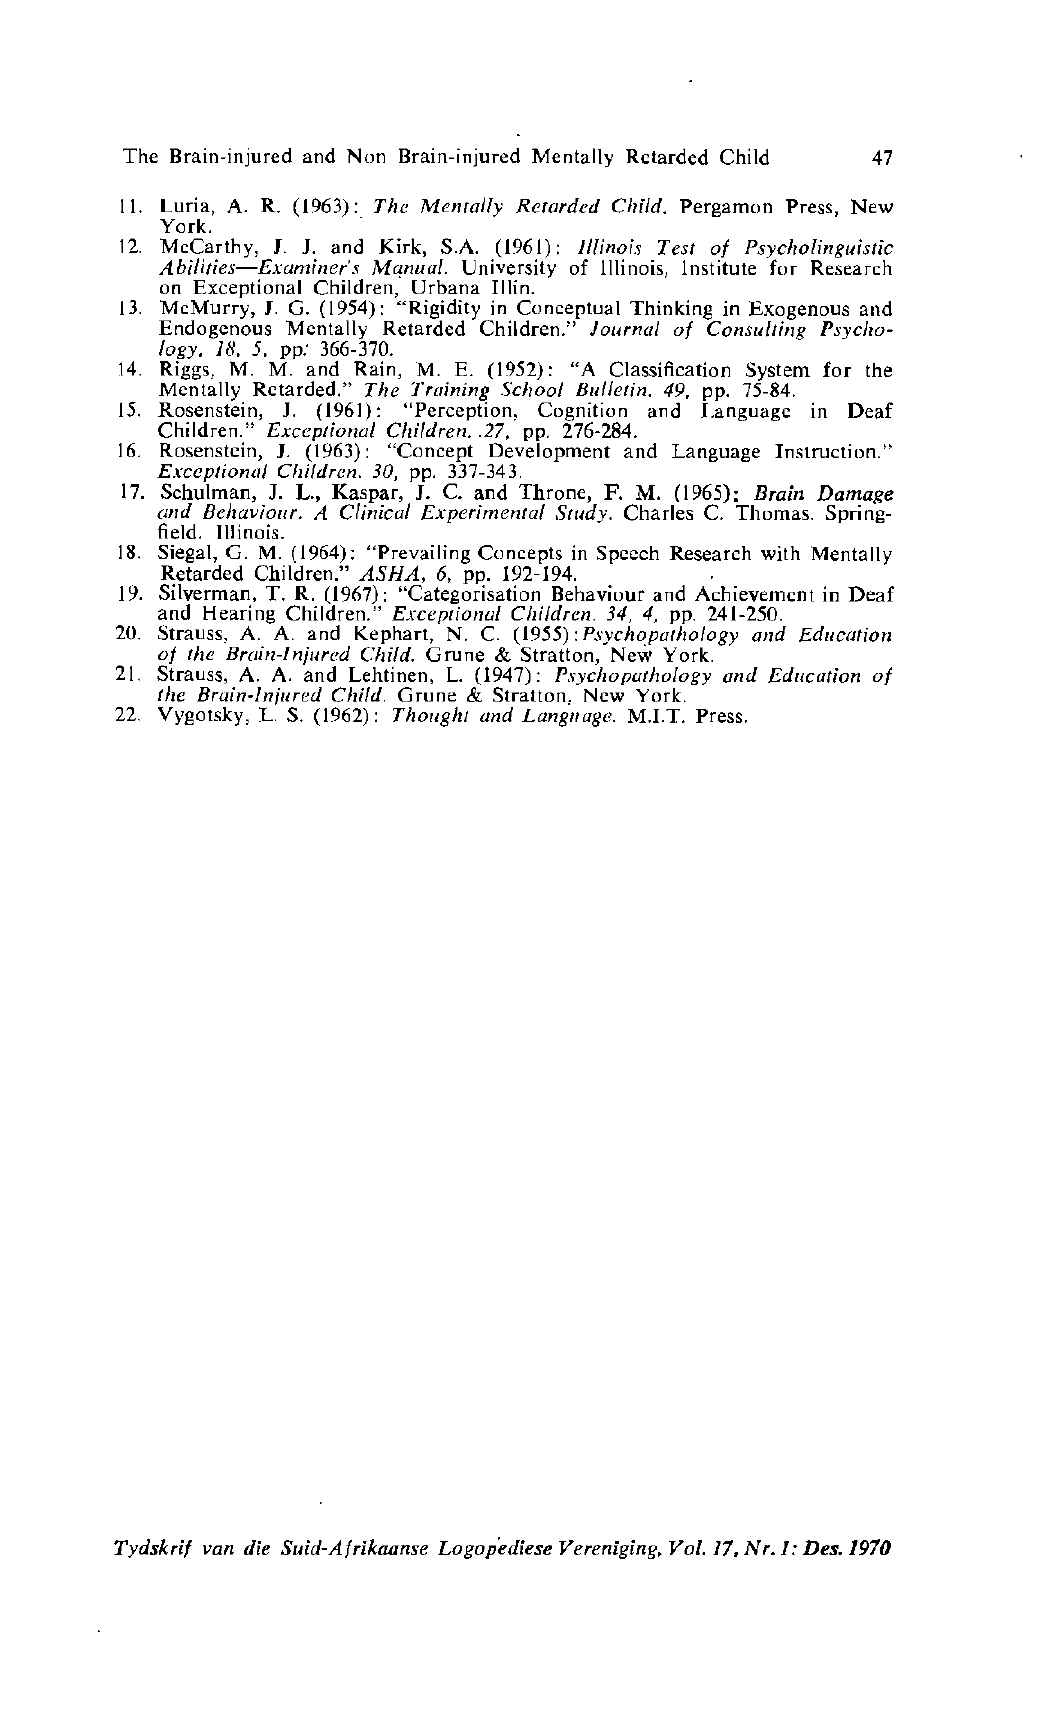
Tydskrif van die Suid-Afrikaanse Logopediese Vereniging, Vol. 17, Nr. 1: Des.